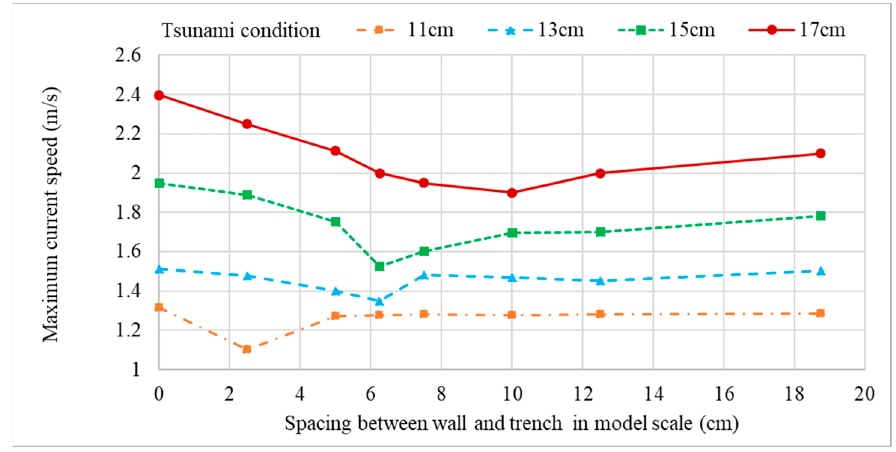
Figure 24. Comparison of maximum current velocity in x direction, observed at location D for different tsunami conditions.